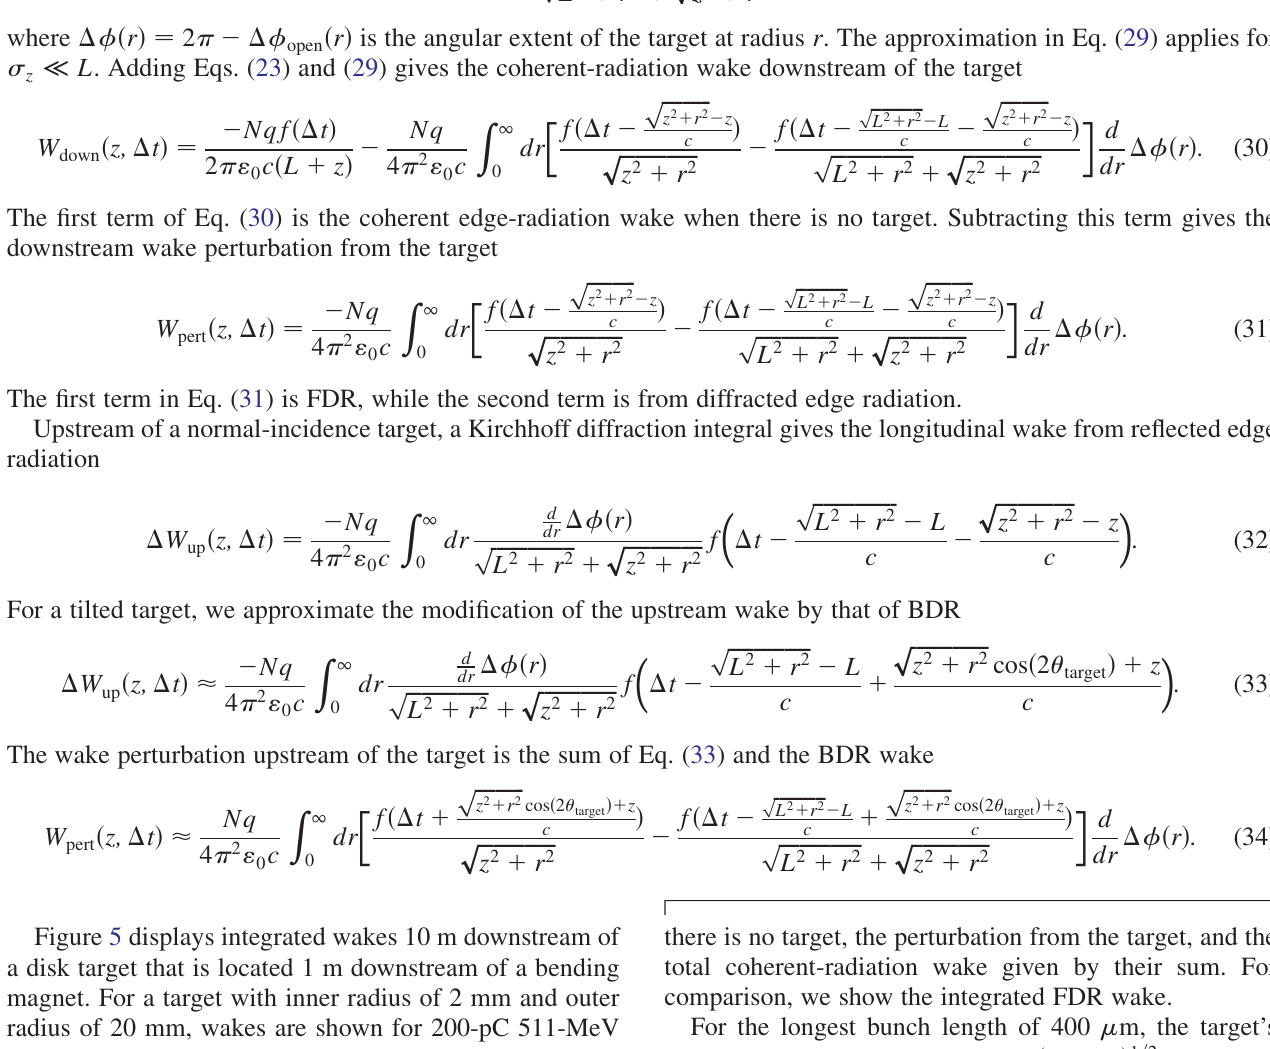
p z 2 þ r 2 p z 2 þ r 2